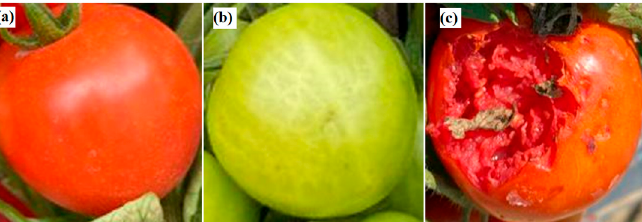
Figure 7. Cropped and normalized images of tomatoes in three states: ( a ) ripe, ( b ) immature, and ( c ) damaged.